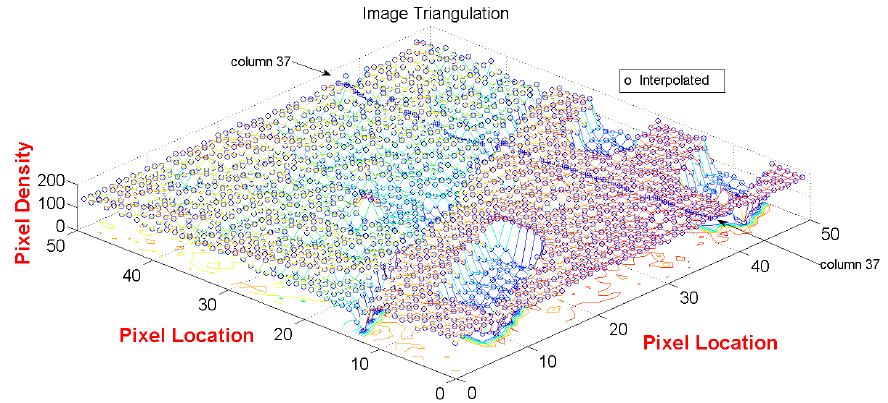
Figure 6. Three dimensional micro-surface of the interpolated points superimposed on the true image surface. The effect of correction factor ɛ in the accuracy of the modified TPS algorithm in grayscale image is studied for a range of values with results shown in Table 1. The method stays accurate for small values of ɛ whose values are comparable to the maximum pixel intensity value in grayscale image, but the method fails when ɛ becomes comparably large. Table 1. Effect of correction coefficient in the accuracy of the modified TPS method. ɛ